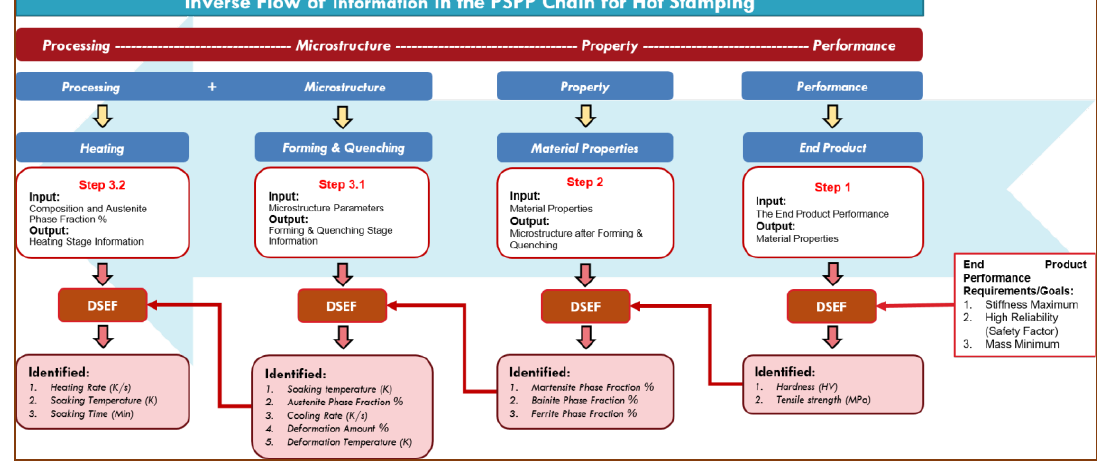
Figure 5. Inverse Flow of Information in Hot Stamping.